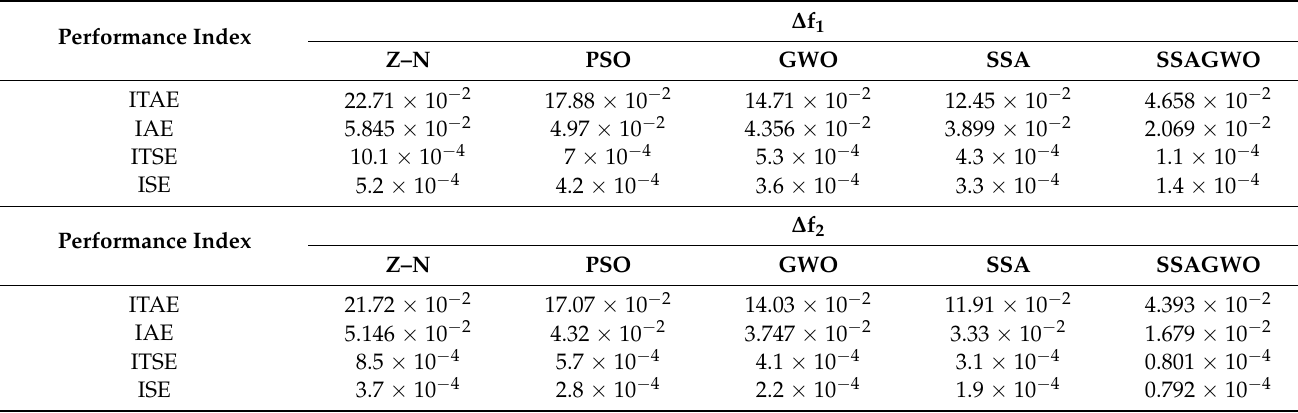
Table 7. Steady-state indices in case II.